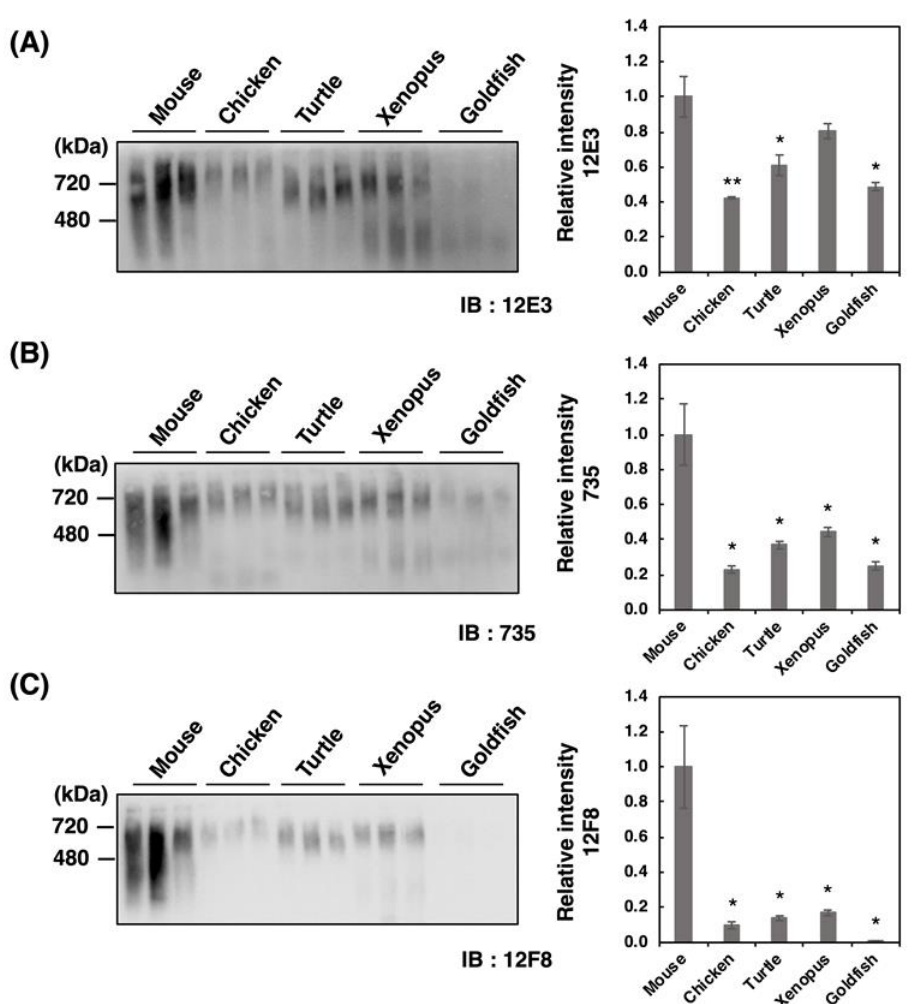
Figure 3. Native-PAGE/Western blotting of polySia-NCAM in brains from five different vertebrates. Brains from five vertebrates (mouse, chicken, turtle, xenopus, goldfish, n = 3) were used. PolySia expression was analyzed using native-PAGE/Western blotting. The brain homogenates of five vertebrate brains were separated by native-PAGE (7% polyacrylamide gel) and blotted onto PVDF membranes (10 µg as protein/lane). The polySia-NCAM was visualized using anti-polySia antibodies, ( A ) 12E3, ( B ) 735, and ( C ) 12F8. The left panel represents the immunoblots. The right panel shows the relative intensity of the polySia antibody. Mouse staining was set to 1.0. * indicates p < 0.05. ** indicates p < 0.01.